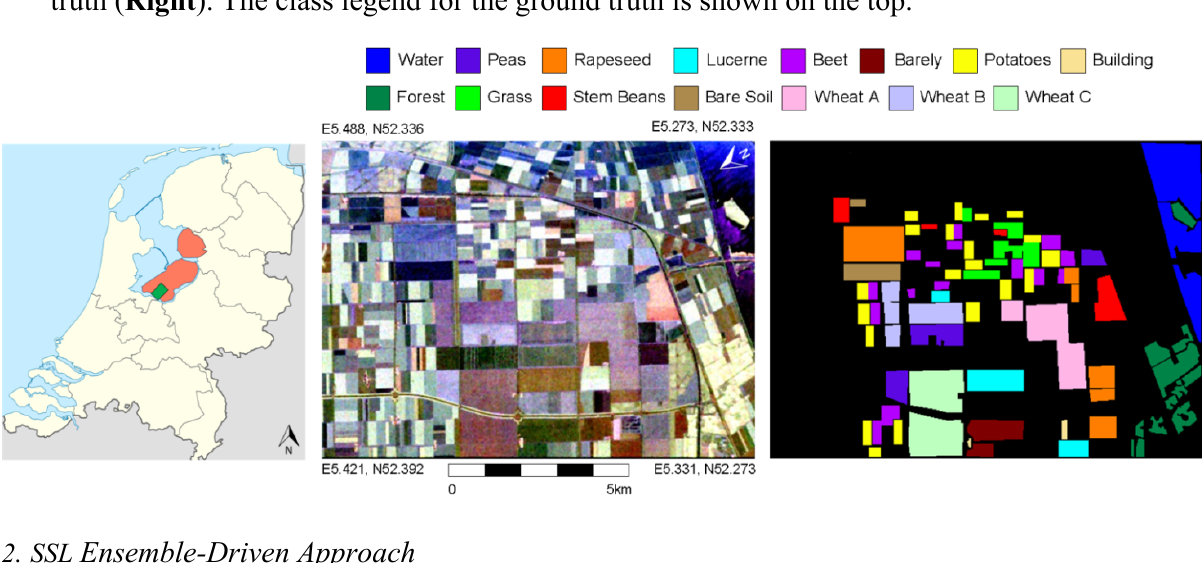
Figure 2. AIRSAR L-Band Flevoland, Pauli color-coded image ( Middle ) and used ground truth ( Right ). The class legend for the ground truth is shown on the